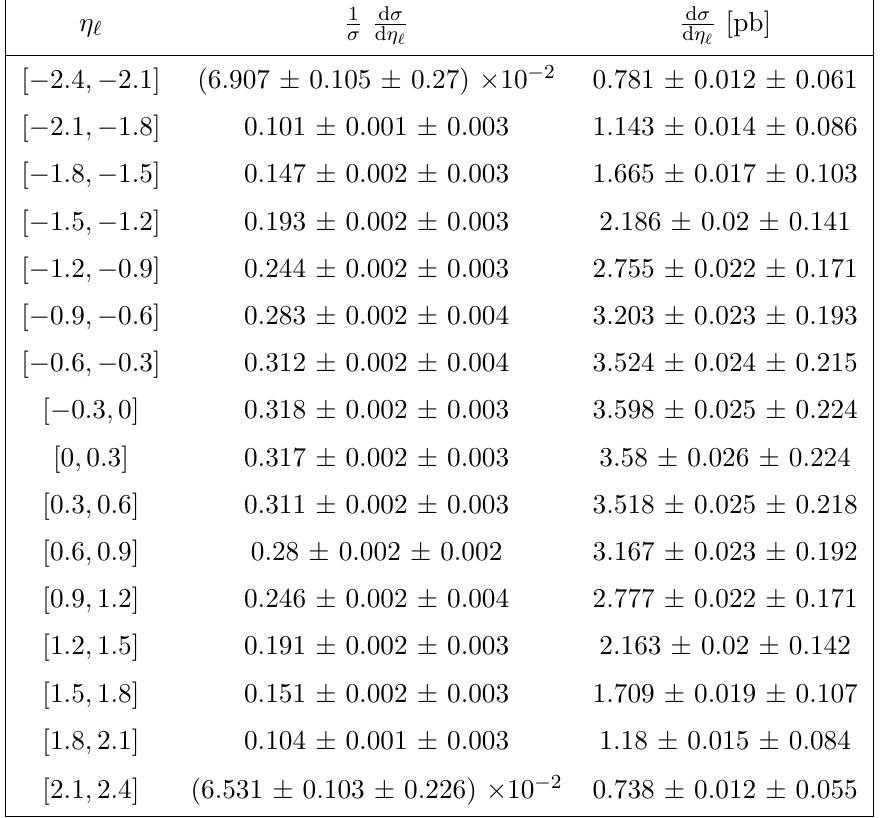
Table 33 . The measured di(cid:11)erential cross section and bin boundaries for each bin of the normalized and absolute measurements of the tt di(cid:11)erential cross section at particle level in the (cid:12)ducial phase space as a function of (cid:17) ‘ are tabulated.